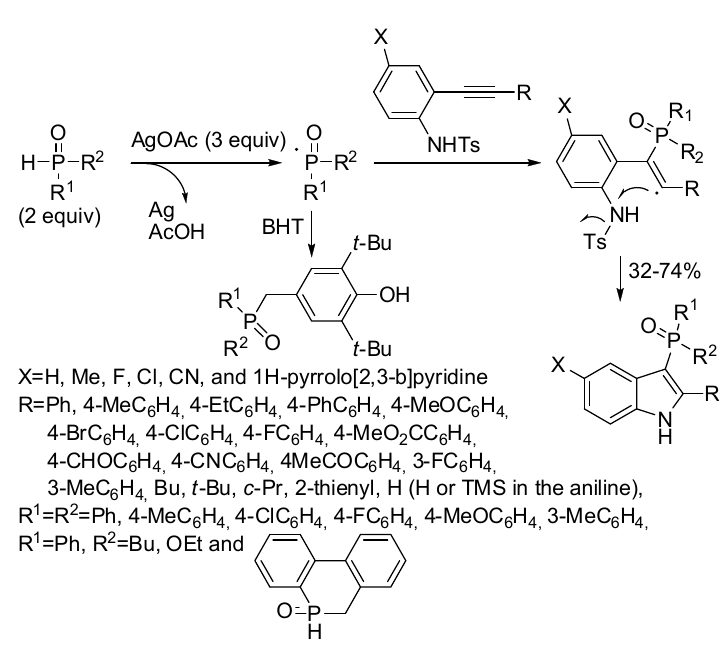
Scheme 69. Synthesis of 3-phosphinoylindoles.